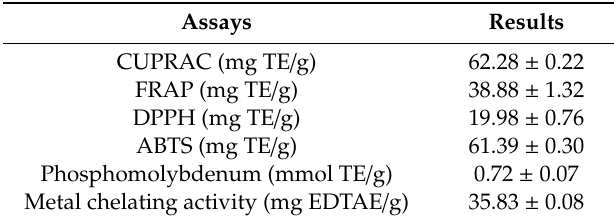
Metal chelating activity (mg EDTAE / g) Values are reported as mean ± SD of three parallel experiments conducted in